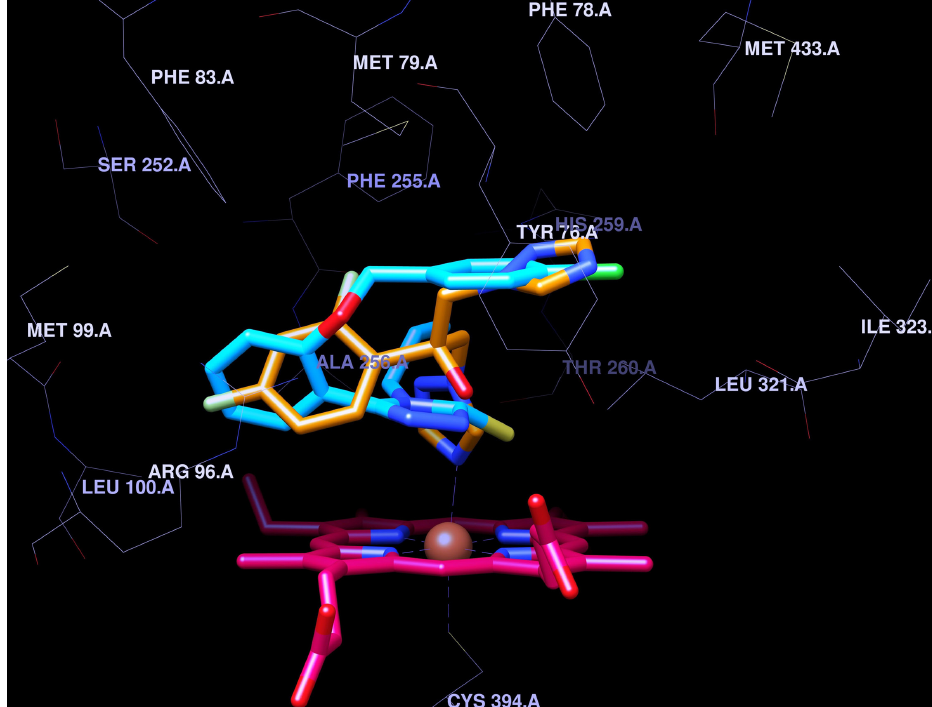
FIGURE 2 - The 3D diagram showing the interaction between the 1EA1.pdb structure and compound 18 (sticks, blue) overlaid on fluconazol FCZ x-ray ligand (stick,